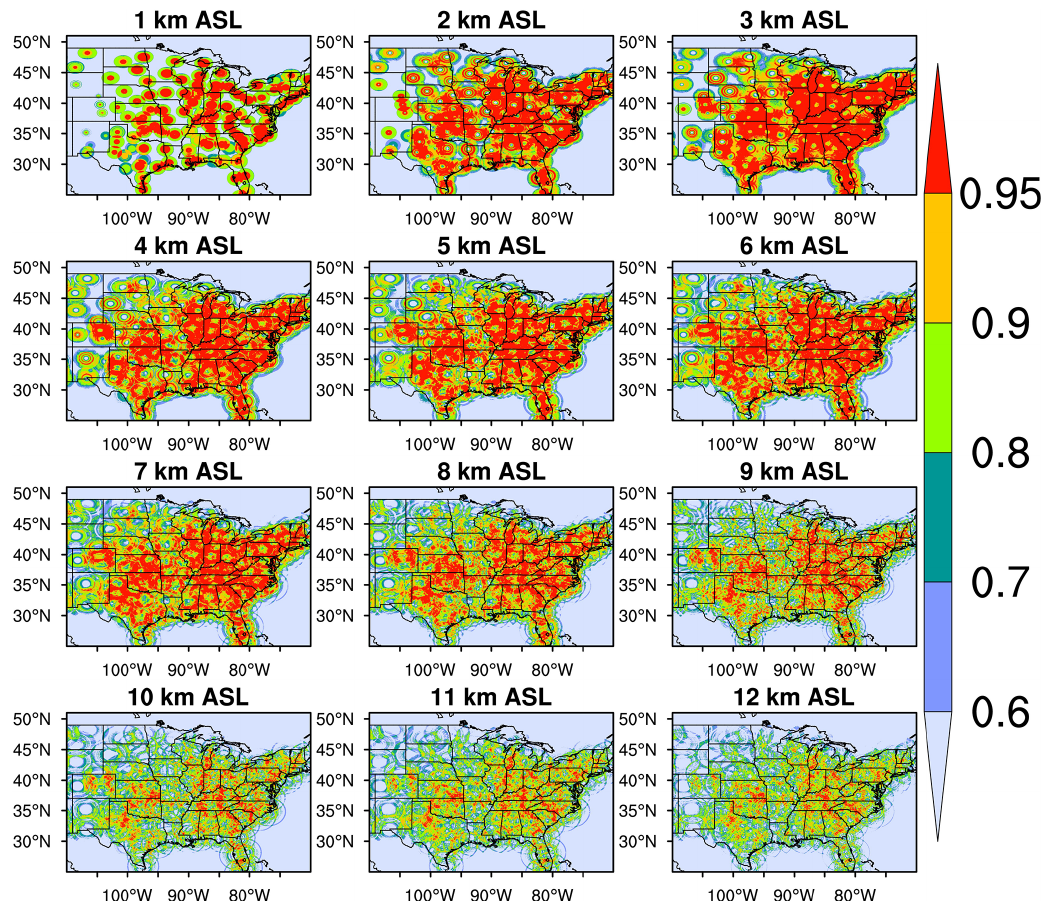
Figure A11. Distributions of the fractions of available radar reflectivity data for 2004–2017 at different vertical levels. As long as radars scan a grid cell, we think of it as “available” even though there is no